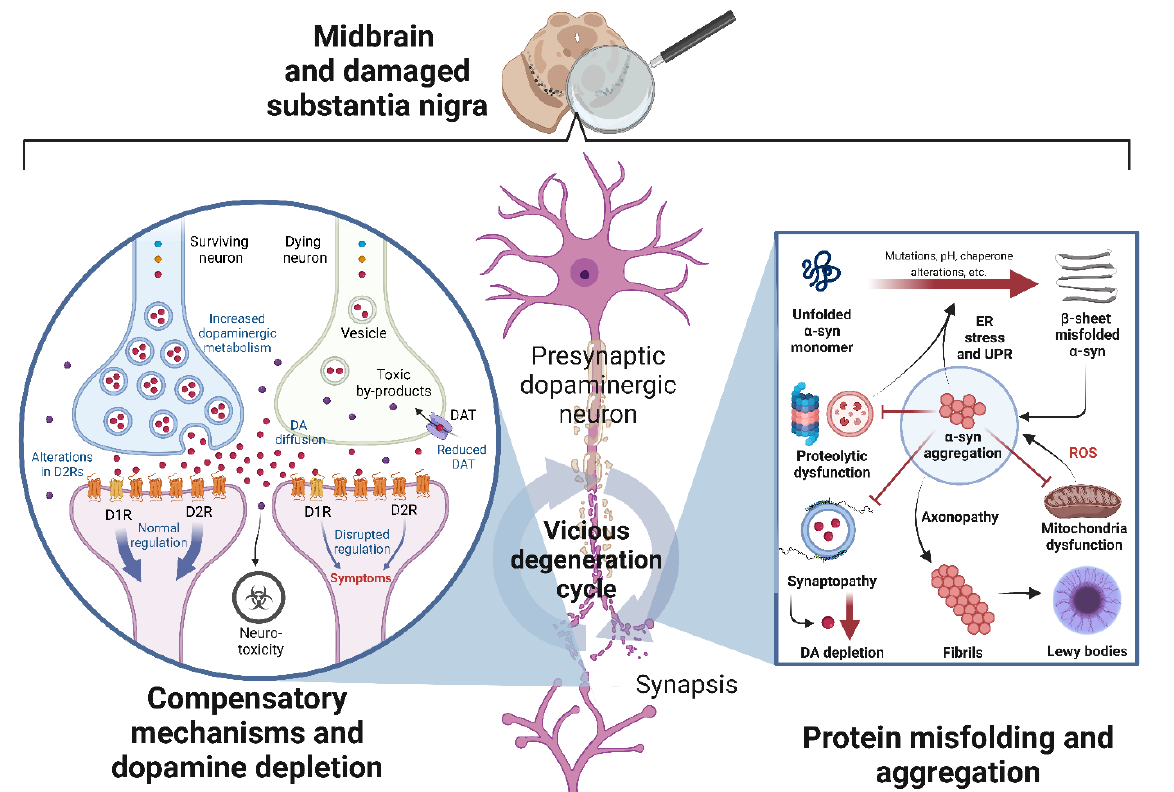
Figure 2. Pathophysiological mechanisms of neurodegeneration: dopamine depletion ( left ) and loss of proteostasis ( right ) in damaged midbrain substantia nigra pars compacta dopaminergic neurons. Upon dopaminergic neurodegeneration, surviving neurons activate compensatory mechanisms to maintain striatal DA concentrations and keep normal motor regulation. Such mechanisms include increased dopaminergic metabolism, alterations in D2Rs, reduced DAT expression, and an incre- ment in DA diffusion. Nonetheless, if neurodegeneration continues, DA depletion translates into a disrupted regulation of motor control and, hence, symptoms. Such neurodegeneration is caused, among other factors, due to the loss of proteostasis. When misfolded into a β -sheet composition due to mutations, pH, or chaperon alterations, α -syn can aggregate. This aggregation disrupts the UPP and ALP proteolytic pathways (inhibiting misfolded α -syn degradation); stresses the ER activating the UPR; causes mitochondrial dysfunction, which generates toxic ROS species that further facilitate α -syn aggregation; alters normal synaptic processes (synaptopathy), which in turn causes a DA depletion; and creates fibrils that travel through axons (axonopathy) into the cytoplasm, where fibrils sequester organelles and proteins to form LBs. Consequently, α -syn misfolding and aggregation generate neurotoxicity in dopaminergic neurons, causing the vicious degeneration cycle observed in PD. DA: dopamine; D1R: dopamine 1 receptor; D2R: dopamine 2 receptor; DAT: dopamine trans- porter; α -syn: alpha-synuclein; ER: endoplasmic reticulum; UPR: unfolded protein response; UPP: ubiquitin-proteasome pathway; ALP: autophagy-lysosomal pathway; ROS: reactive oxygen species; PD: Parkinson’s disease. Figure made in BioRender.com.